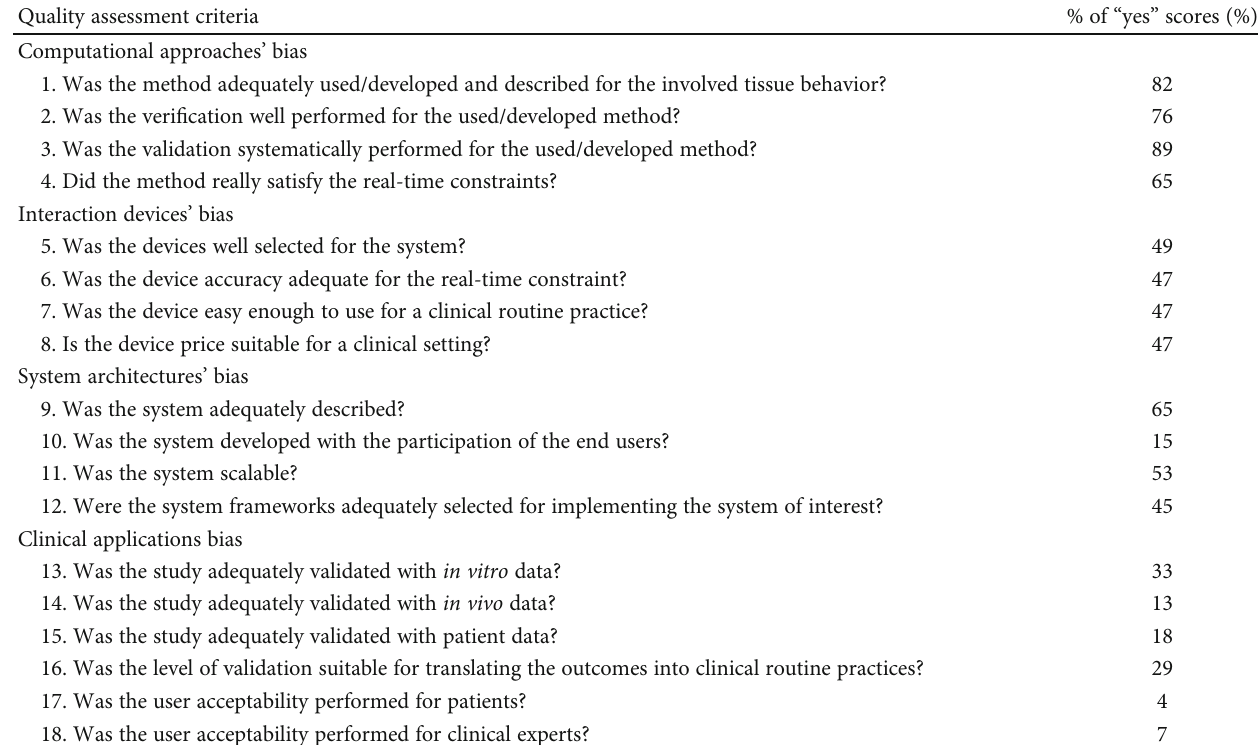
Table 4: Summary of the statistical results of the quality assessment procedure. Quality assessment criteria Computational approaches ’